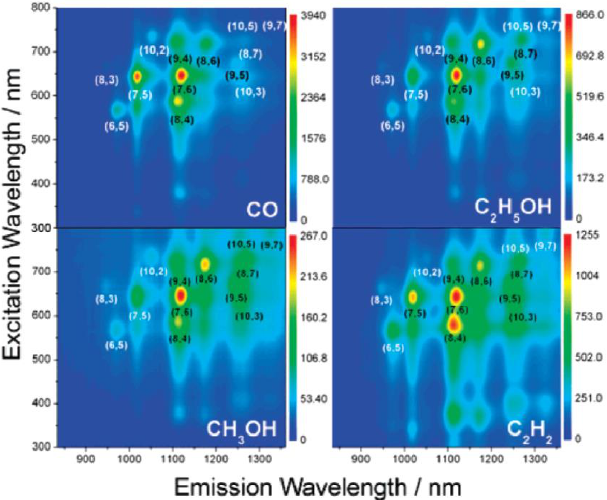
Figure 4. Maps of photoluminescence intensity versus excitation and emission wavelength (in nm) for SWCNTs grown from several feedstocks: CO, C 2 H 5 OH, CH 3 OH, and C 2 H 2 [38]. Copyright 2007, American Chemical